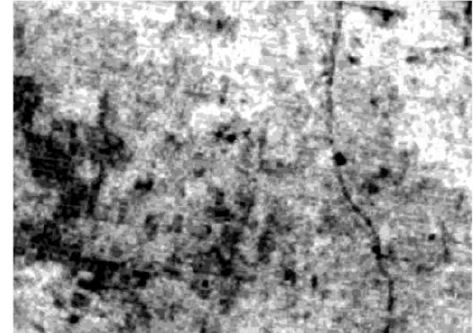
Figure 6. The forth component inversed from stacking data